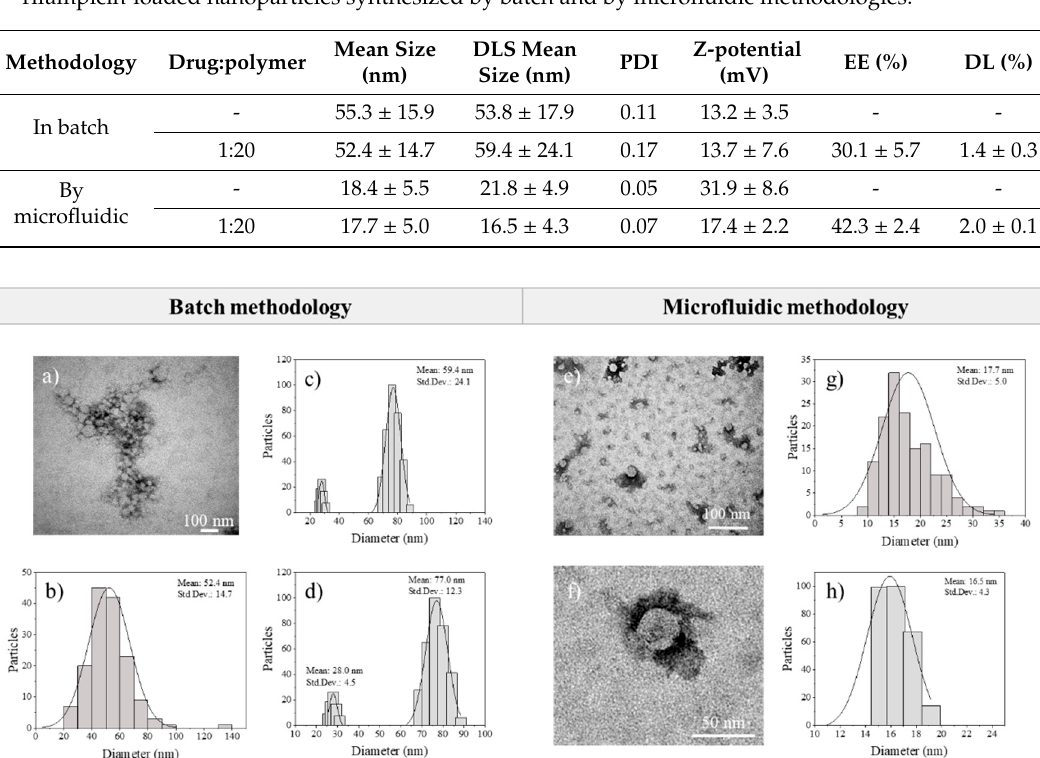
Figure 12. ( a – d ) Rifampicin-loaded nanoparticles by batch methodology: ( a ) SEM micrograph, ( b ) size distribution from SEM images, ( c ) DLS size distribution, ( d ) peak analysis of DLS distribution. ( e – h ) Rifampicin-loaded nanoparticles by microfluidic methodology: ( e ) SEM micrograph, ( f ) zoomed SEM micrograph, ( g ) size distribution from SEM images, ( h ) DLS size distribution.